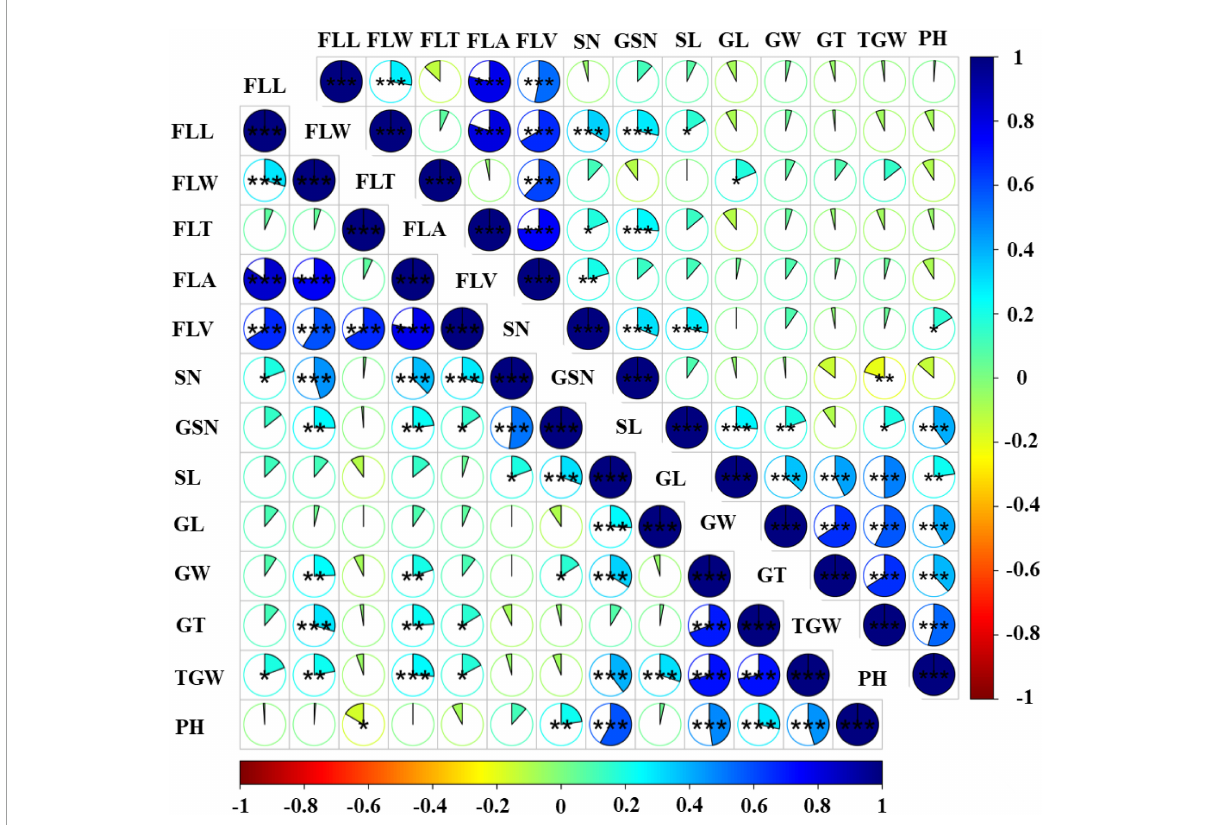
FIGURE2 Phenotypic correlation coefficients between flag-leaf-related traits and yield related traits in the DH population grown under two water regimes. The lower left triangular matrix represents rainfed conditions, the upper right triangular matrix represents WW conditions, the sector area represents the correlation coefficients. *Significant at P < 0.05, **significant at P < 0.01, ***significant at P <